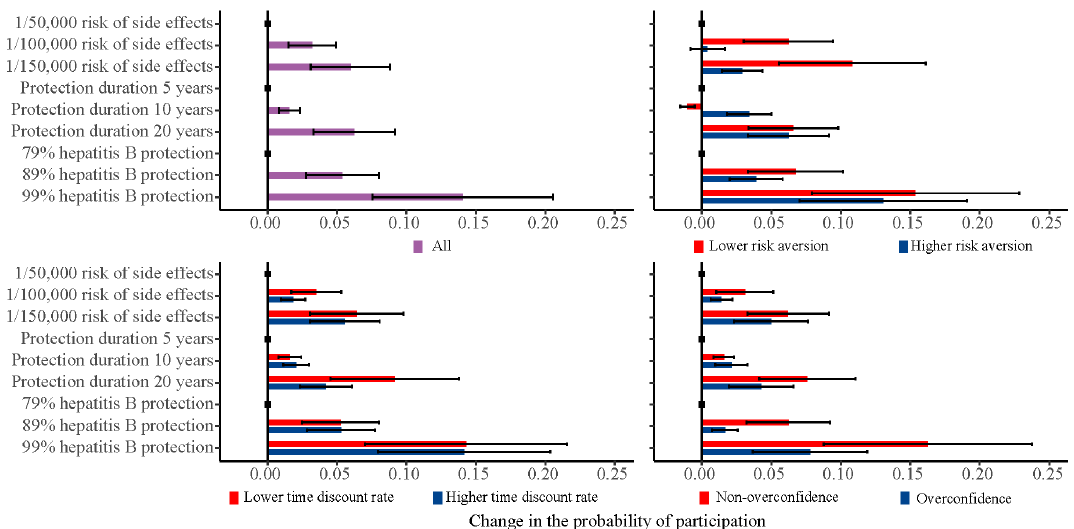
Figure 1. Univariate marginal estimates for predicted probability of participation.